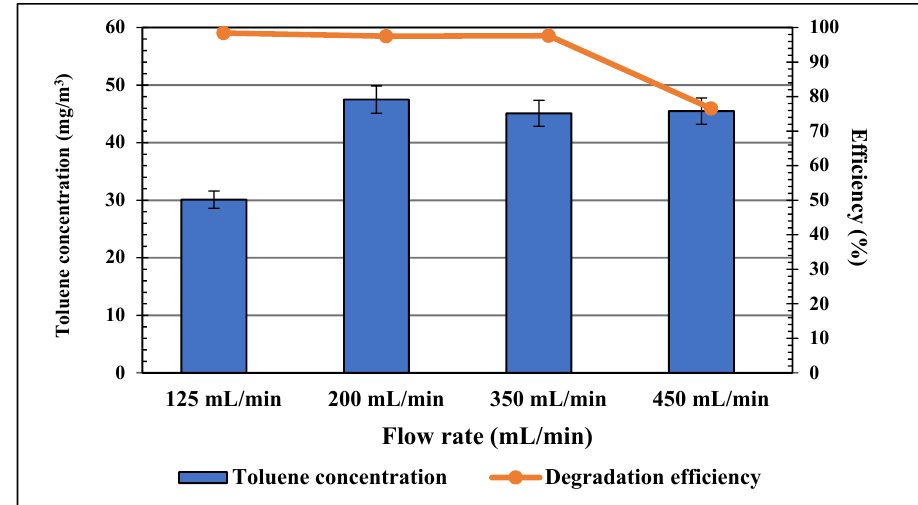
Figure 9. Effect of flow rate on photodegradation efficiency of toluene at 1.5 mol% Ir, φ = 70%.